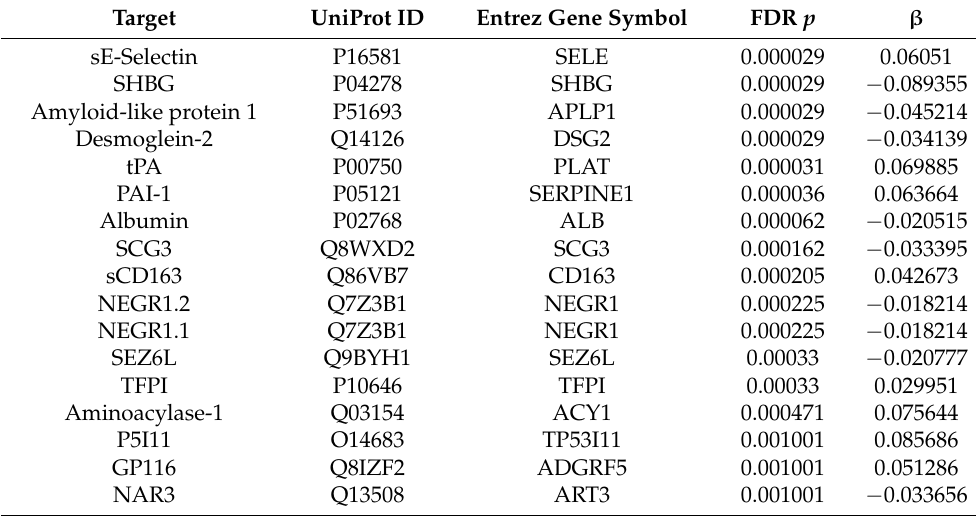
Table 2. The 84 proteins significantly associated with the apnea–hypopnea index (AHI) after 5% FDR